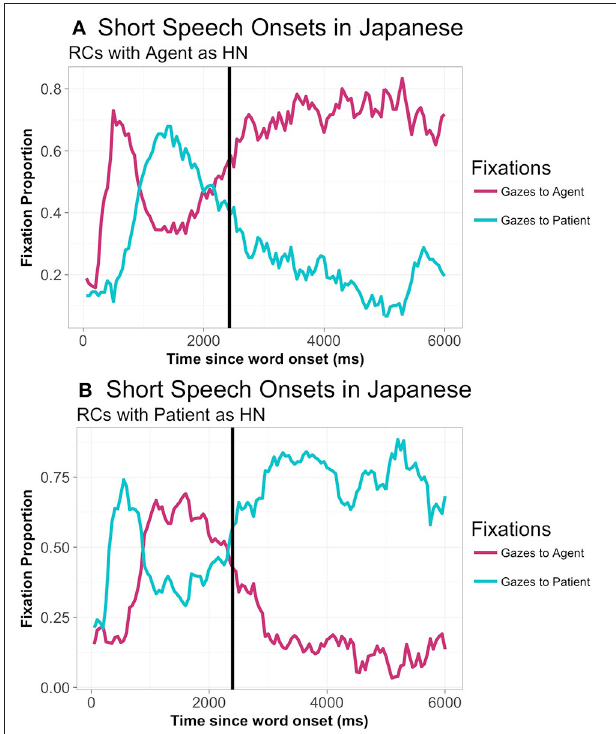
FIGURE 9 | Gaze patterns to agent and patient in Japanese RCs with the agent as HN (A) and with the patient as HN (B) (all animacy combinations collapsed), only in responses with speech onsets from 1,000ms to 3,000ms.: From picture onset until 7,000ms. The vertical line represents the average SO.